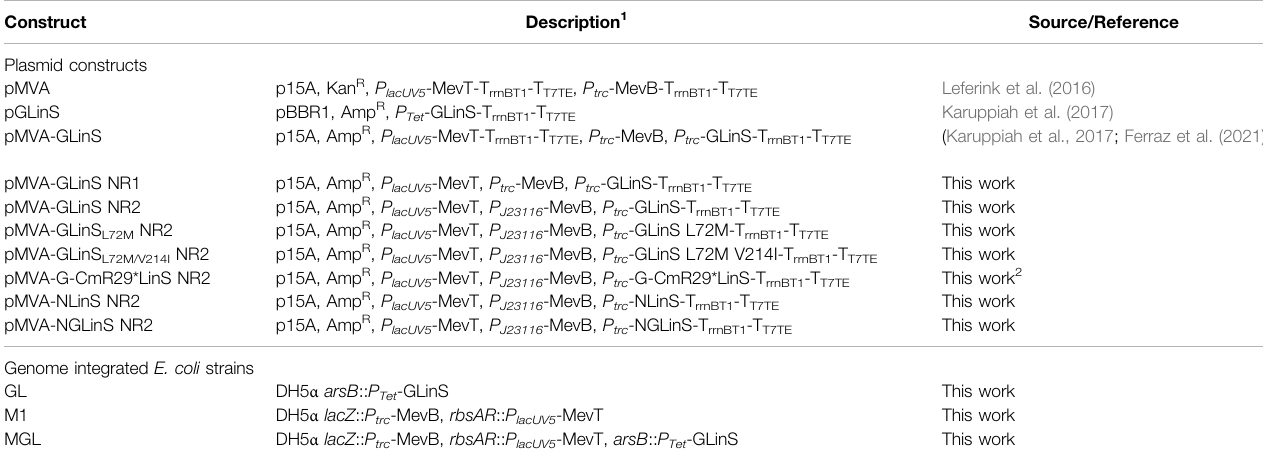
TABLE 1 | Linalool pathway plasmids and genomic integrated strains used in this